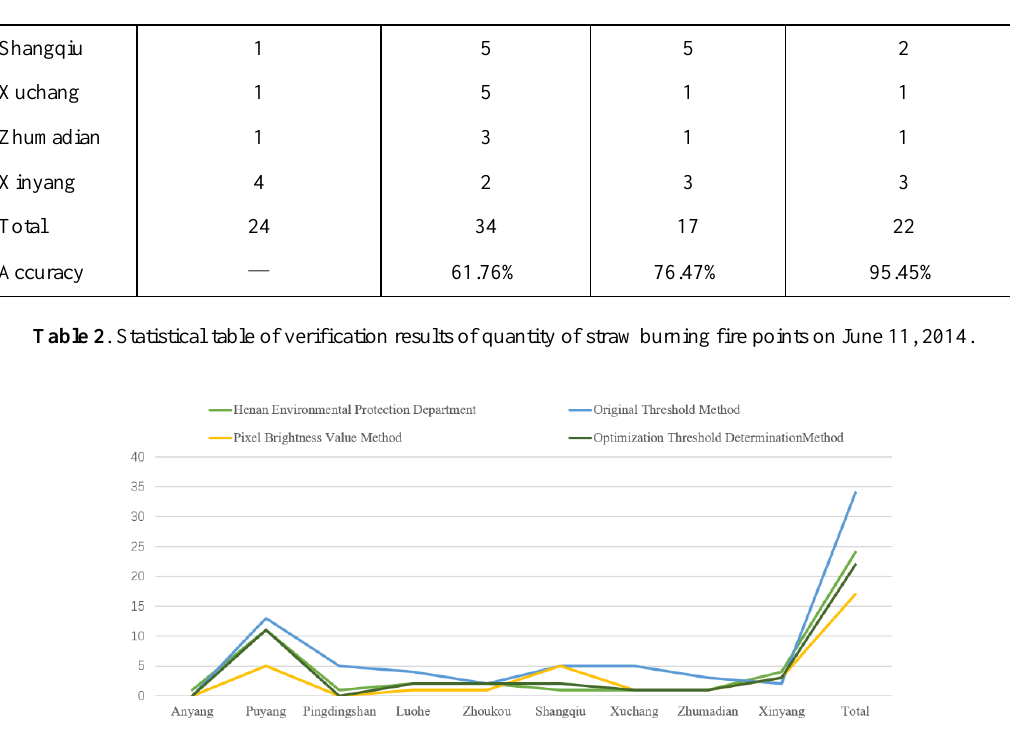
Figure 4 . Comparison and statistics of the number of recognized straw burning fire points on June 11, 2014.